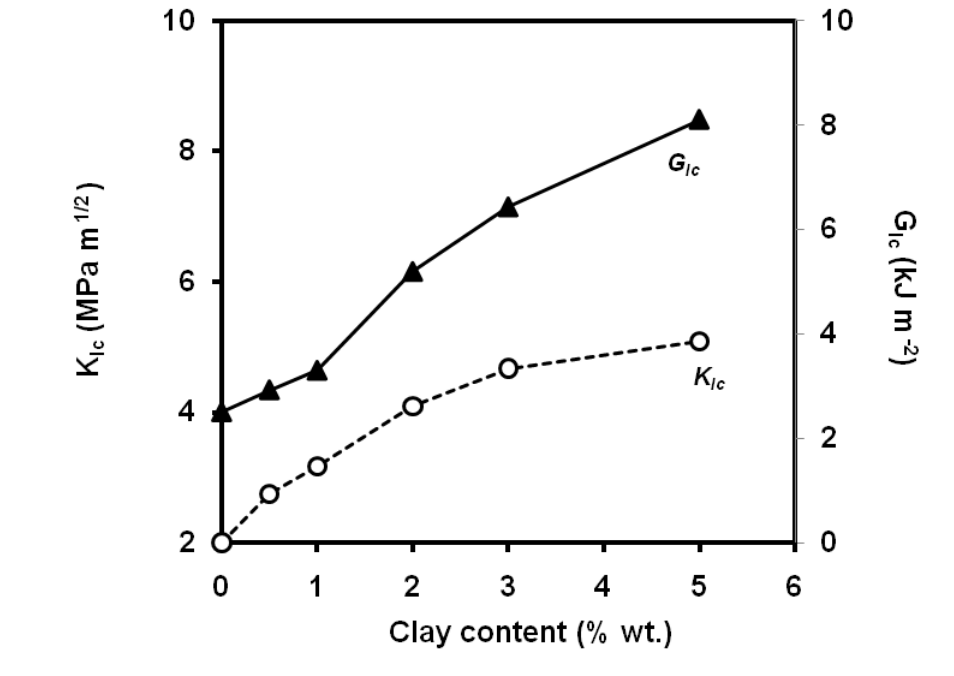
and G values composites.(adapted Ic Ic